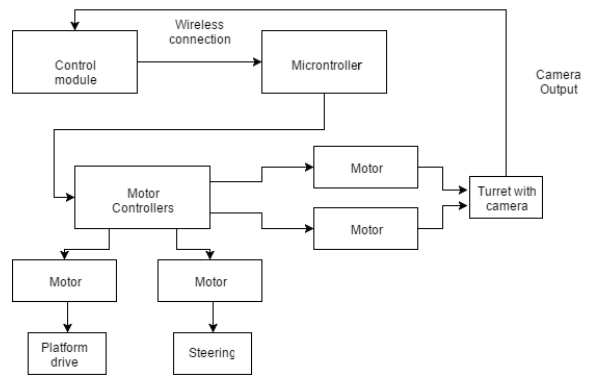
Figure 6: Scheme of the